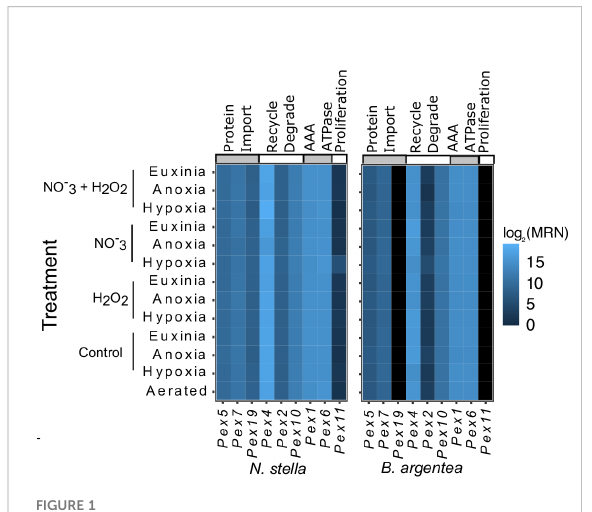
FIGURE 1 Heatmap presented by species showing the log 2 transformed median ratio normalization (MRN) values for all the identi fi ed peroxisome biogenesis genes. Black indicates no